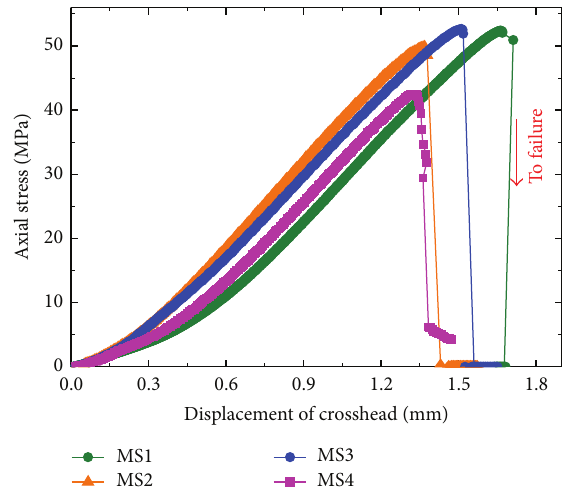
Figure 3: Dynamic rupture in concrete (samples are labeled as MS1, MS2, MS3, and MS4) under monotonic loading at a constant displacement rate (0.05 mm/min). The specimens fail suddenly in thepostfailurestageafterthepeakforceisreached.Concreteexhibits some scatter in the attained peak force and failure strain. In these monotonic tests, the displacements in the brittle creep tests are selected to be the same as those corresponding to the 80–90% peak